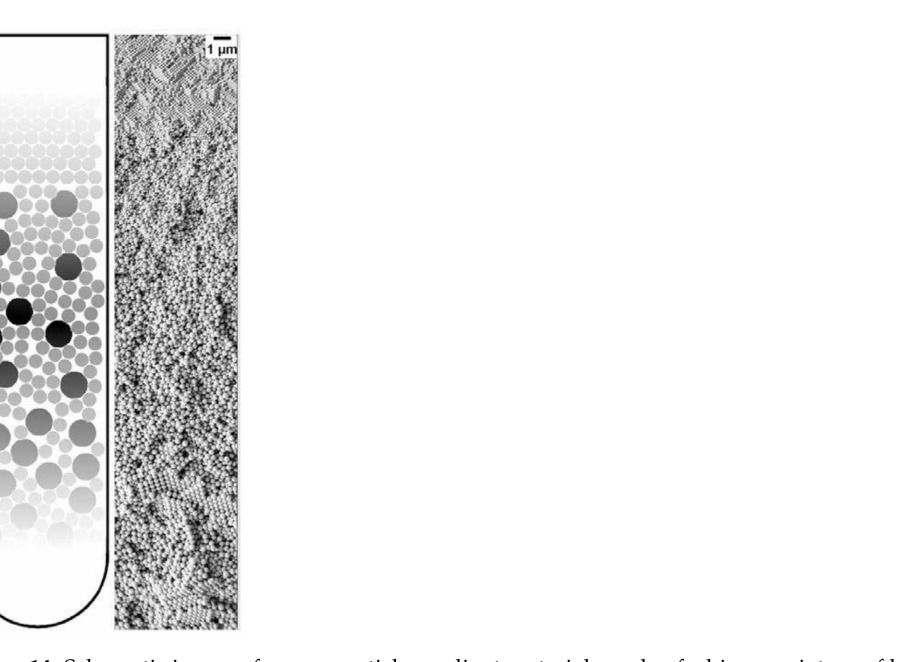
Figure 14. Schematic image of a nanoparticle gradient material, made of a binary mixture of latex nanoparticles ( left ) and a representative SEM image of this gradient structure ( right ). Reproduced with permission from [107], Copyright the American Chemical Society,